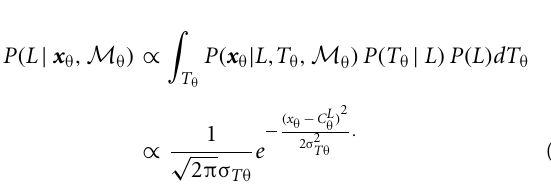
nature of the templates in terms of orientation information for each edge or limb segment. The mathematical terms are defined in the